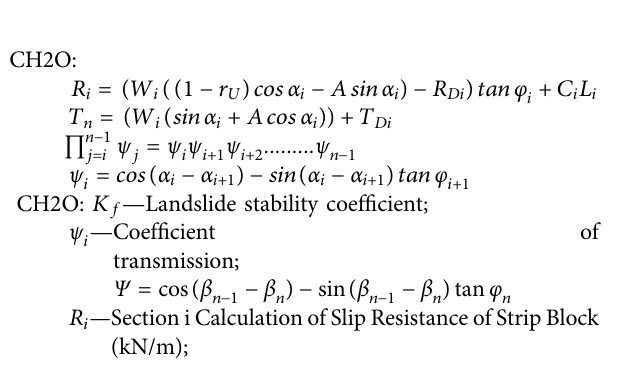
R — Section i Calculation of Slip Resistance of Strip Block i